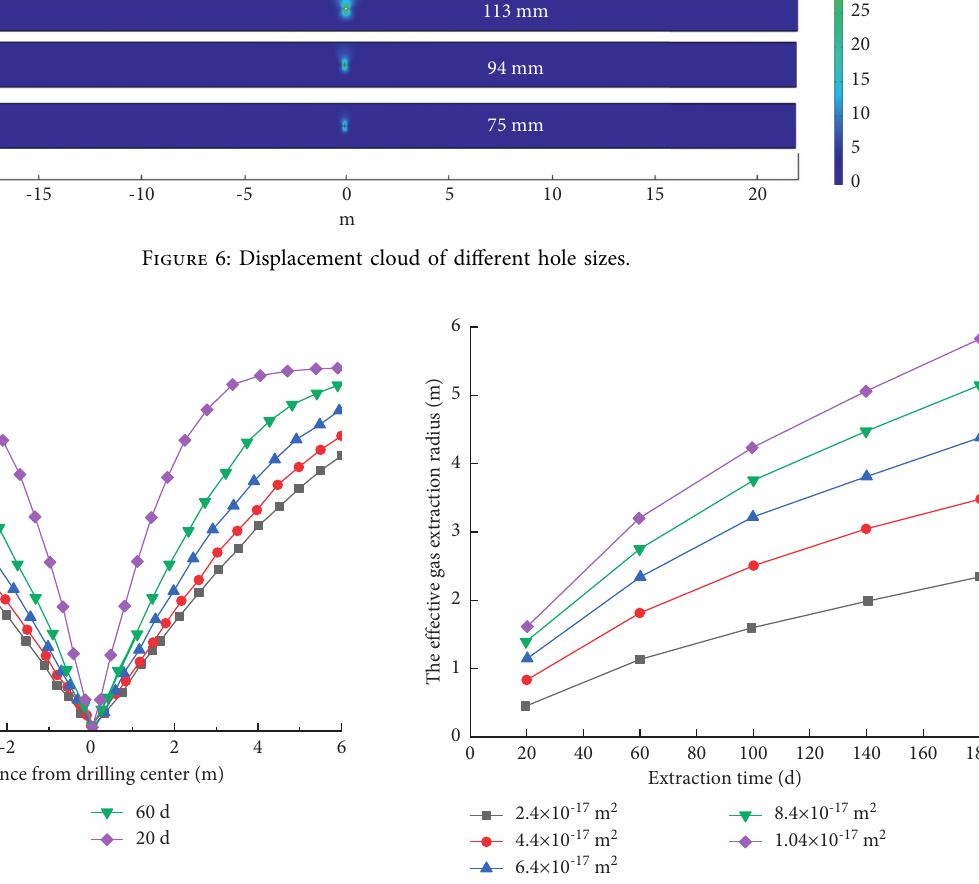
Figure 7: Gas pressure distribution curve around Table 2: Effective extraction radius of different extraction time. Extraction time (d)